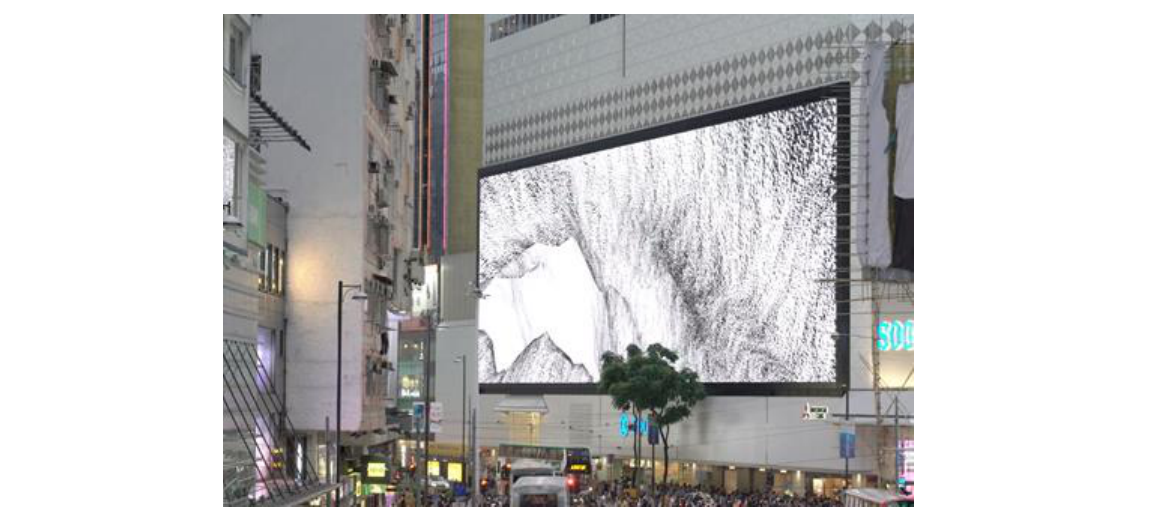
Figure 2 Black Move, Hong Kong, China (Source: Videotage,